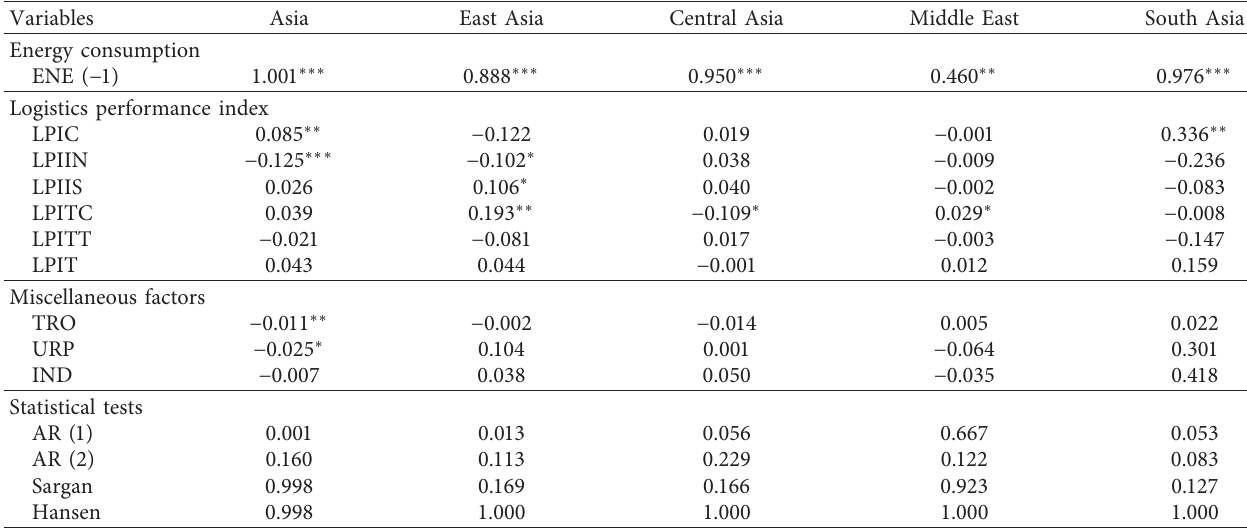
Table 4: System GMM panel estimation regression